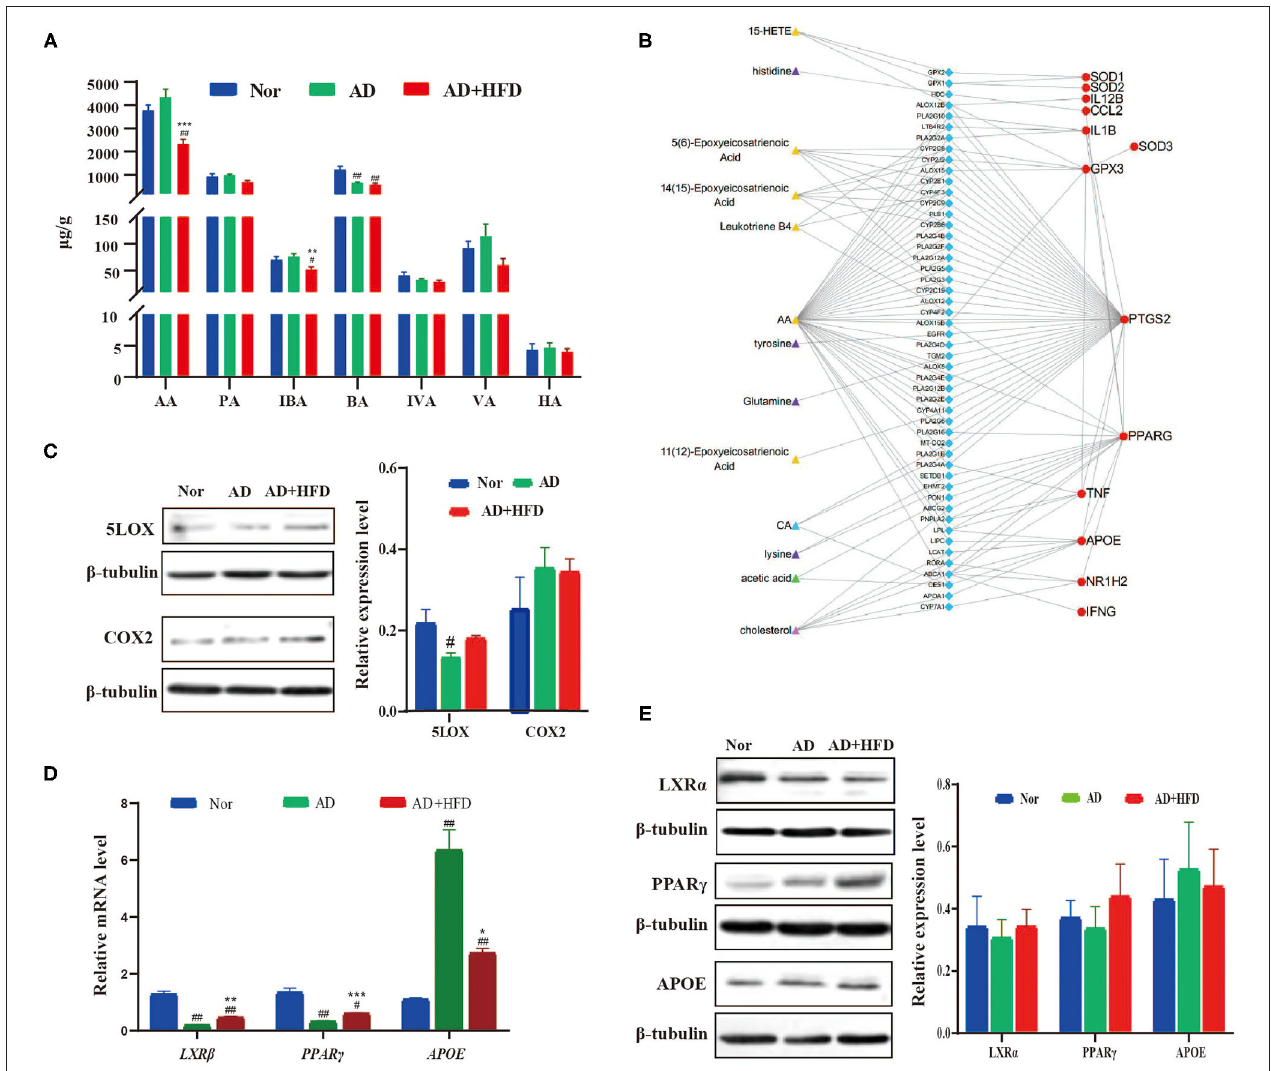
FIGURE 5 | Network visualization analysis of metabolite-protein interaction in high fat treated mice. (A) The SCFA level changed by high fat diet. (B) Network visualization analysis of metabolite–enzyme (blue) –protein (red) interaction. The metabolites in which were significant changed in AD + HFD mice compared with AD mice. And the related protein detected by RT-PCR (C) and Western blot (D,E)